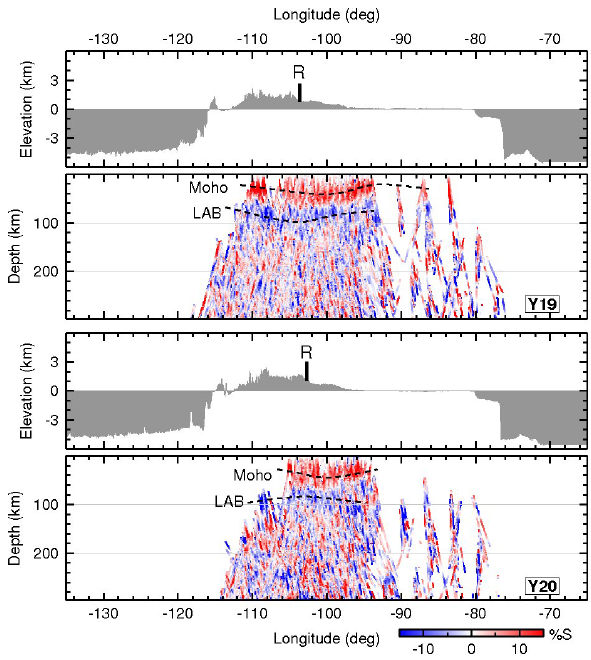
Fig. 12. Migrated S receiver functions along profiles Y19 and Y20 as in Fig. 3. Migrated S receiver functions along profiles Y19 and Y20 as in Fig. 3.